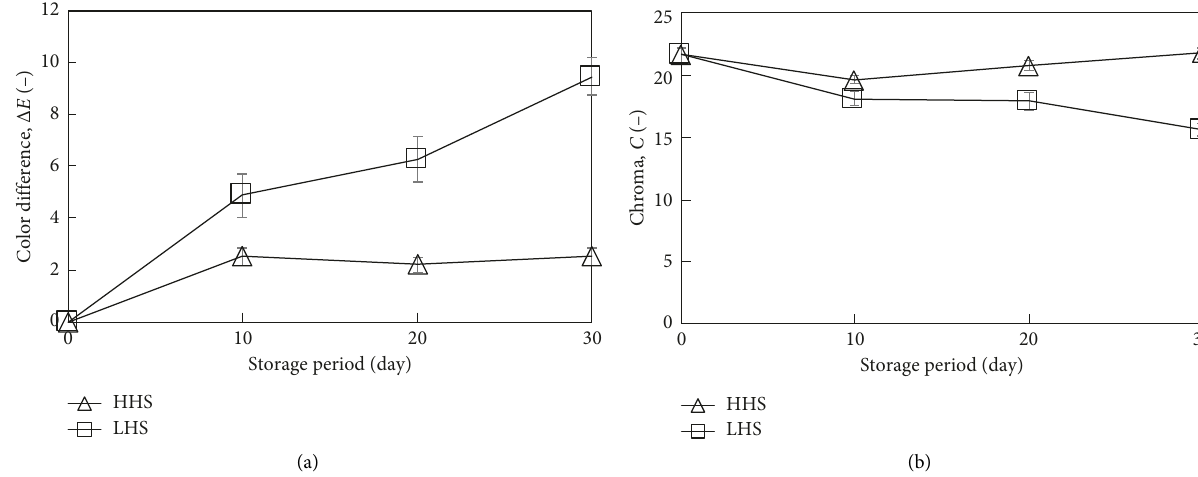
Figure 3: Changes in color properties of “Shine Muscat” fruit during storage: (a) color difference; (b) chroma. HHS: high storage humidity sections; LHS: low storage humidity sections. Error bar shows standard error ( n � 10 − 12).